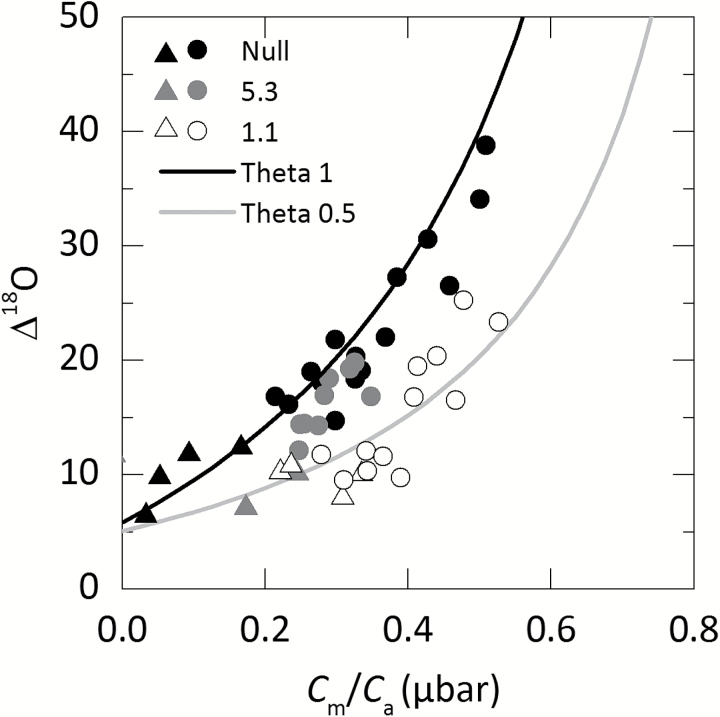
Oxygen isotope discrimination (Δ18O) as a function of the ratio of mesophyll pCO2 to ambient pCO2 (Cm/Ca) in null and lines 5.3 and 1.1. Each point represents a measurement made on an individual leaf of a T2 plant. Triangular symbols represent measurements made at low pCO2. Theoretical curves represent the scenario where cytosolic CO2 is at full isotopic equilibrium with cytosolic water (θ=1, black) or under partial equilibrium (θ=0.5, grey) of 18O in the leaf. The equations for the curves are given by ΔO 18=a18+CmCa−Cm(δc−δa)  and a18=5.85‰ and δc–δa=33‰ at full equilibration or a18=5.1‰ and δc–δa=15‰ (Farquhar and Lloyd, 1993).